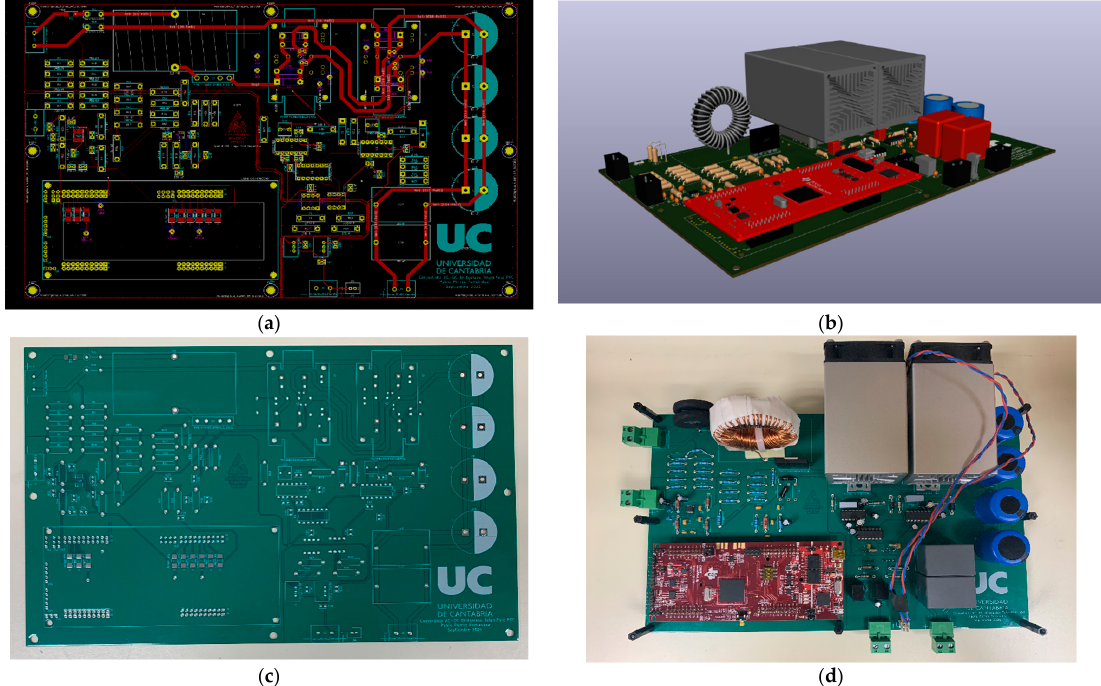
Figure 6. PCB design and building the converter. ( a ) Detail of the connections of the upper layer of the designed PCB, ( b ) 3D recreation of the designed PCB, ( c ) upper face of the built PCB, and ( d ) final assembly of the converter prototype, including LAUNCHXL-F28379D board. Table 3. Characterization of the prototype inductance.